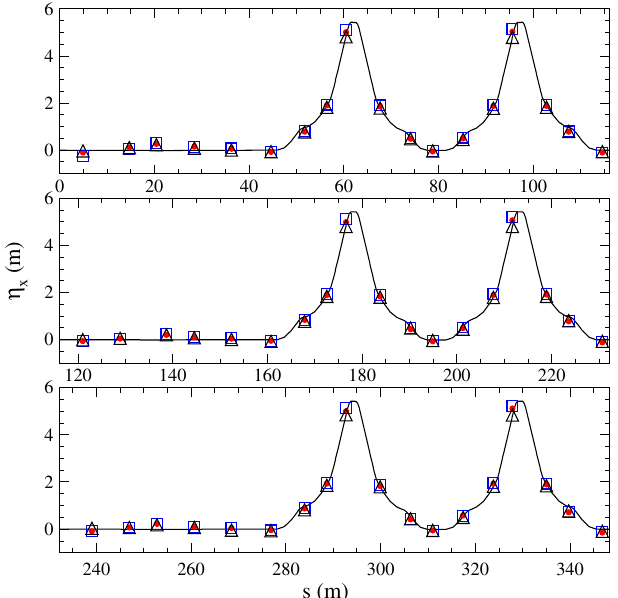
FIG. 25. Flattop wave forms of the extraction kickers before (a) and after (b) the relative timing adjustment among the kickers.